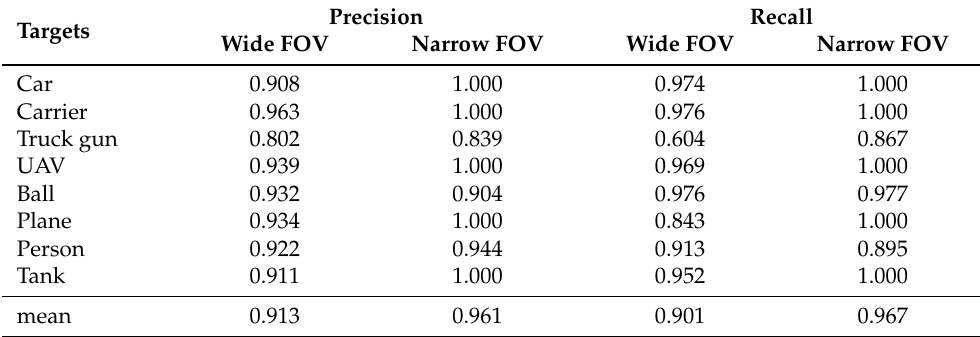
Table 8. Target recognition results of AOCNet in different